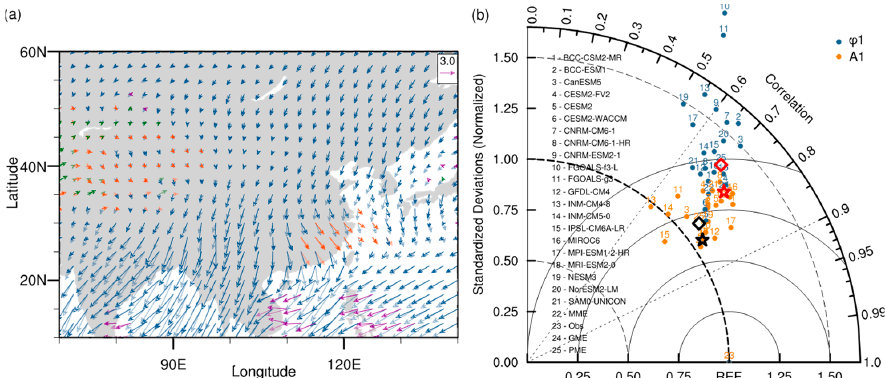
Figure 3. Simulation on the spatial distribution of the gridded A 1 and ϕ 1 of the annual cycle components over EA. ( a ) vector map for the annual cycle 73-pentad clock in observation (OBS) and MME. The length of the arrow quantifies the A 1 . The clockwise rotated vector with the northward vector indicates the ϕ 1 at Julian pentad 1 and a total 73 pentads evenly distributed within 360 ◦ . The red, blue, purple, and green arrows represent the ϕ 1 in spring, summer, autumn, and winter. The opaque and translucent arrows indicate the simulations and observations, respectively. ( b ) Multivariable Taylor diagram of the A 1 and ϕ 1 of the annual cycle component. The star and diamond markers represent the GME and PME, as discussed later in Section 4.